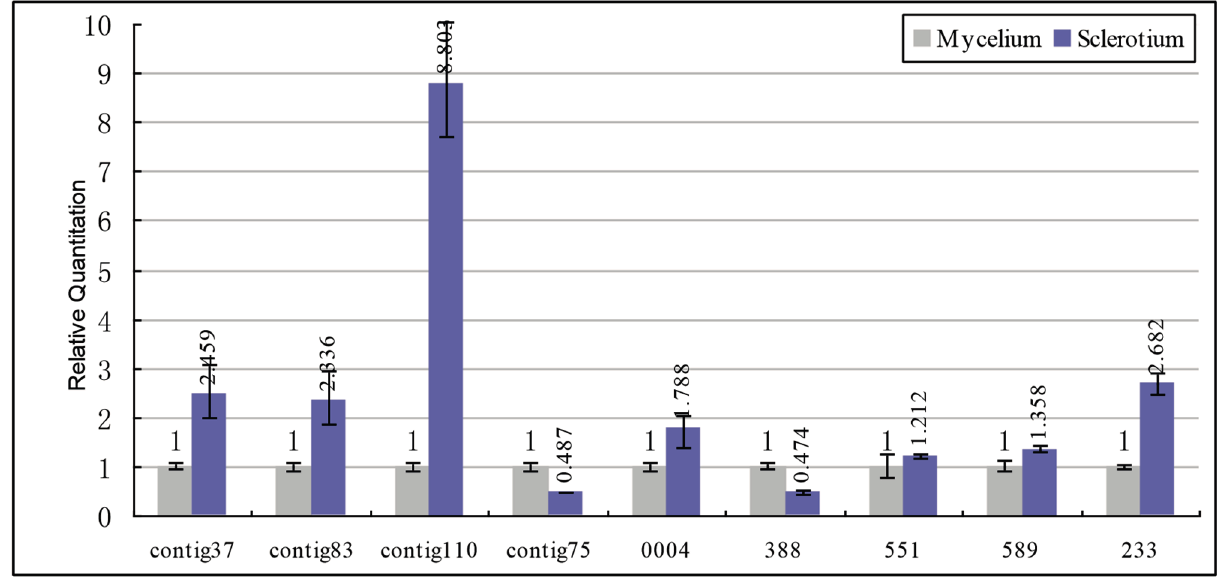
Figure 4. Expression patterns of redox related genes from SSH library using qPCR analyses. Blue columns represent the Relative Quantification (RQ) in sclerotium; light grey columns indicate the RQ in mycelium. All standards were run in duplicate and samples were run in triplicate. Contig37: glyoxal oxidase; Contig83: choline oxidase; Contig110: NADPH oxidase; Contig75: glutathione peroxidase; 0004: peroxisomal membrane protein; 388: cysteine peroxidase; 551: thioredoxin-dependent peroxidase; 589: chloroperoxidase-like protein; 233: alcohol oxidase-like